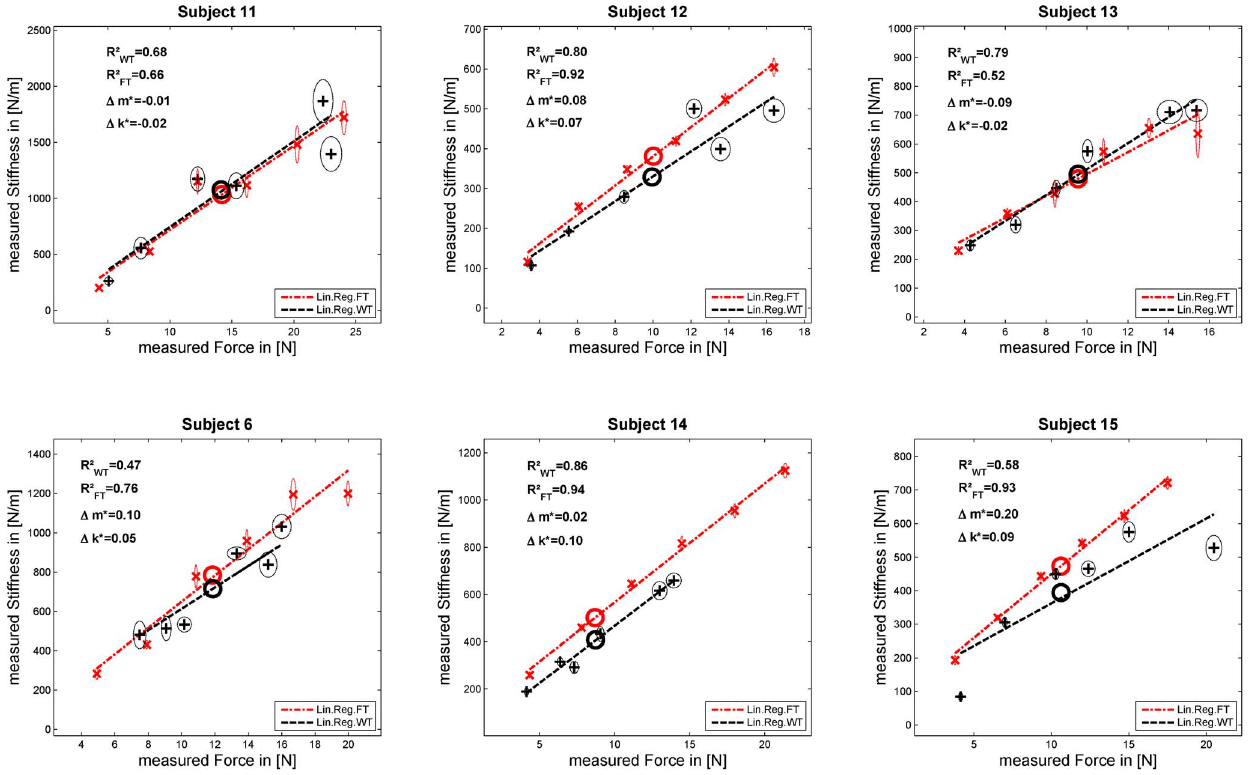
Figure 7. Results Experiment 3. Subjects who performed the experiment with the wrist cuff (WT first: top row, FT first: bottom row).